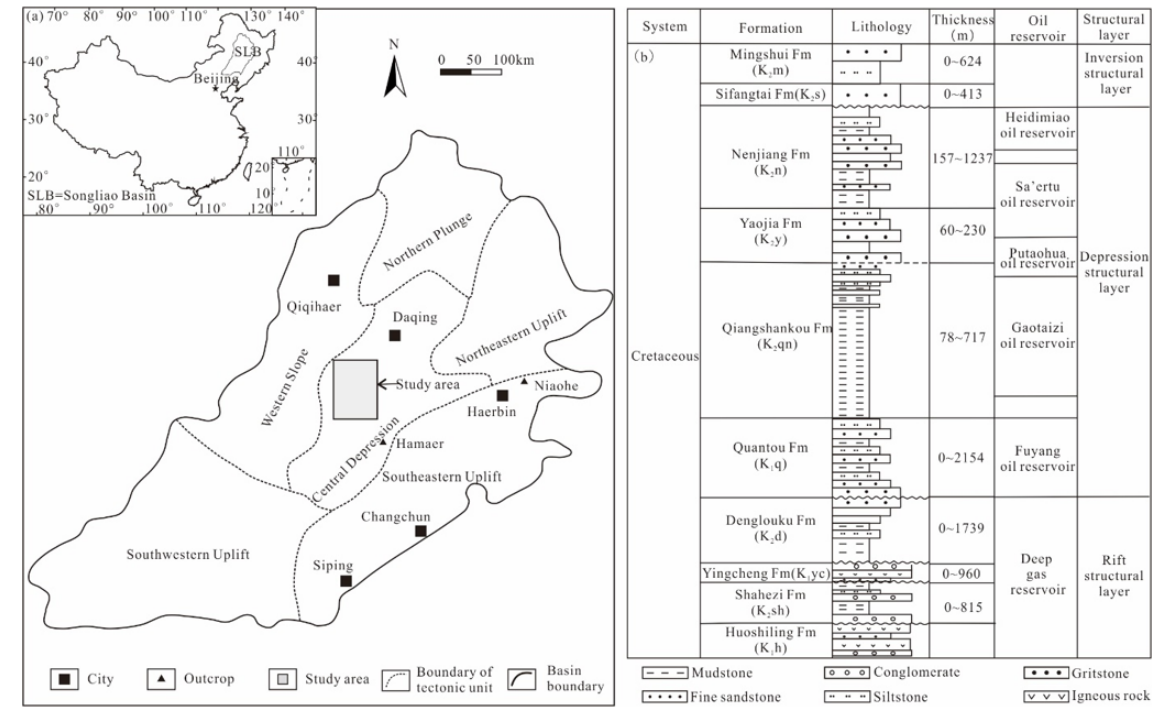
Figure 1. Structural units of the Songliao Basin and the location of the study area.